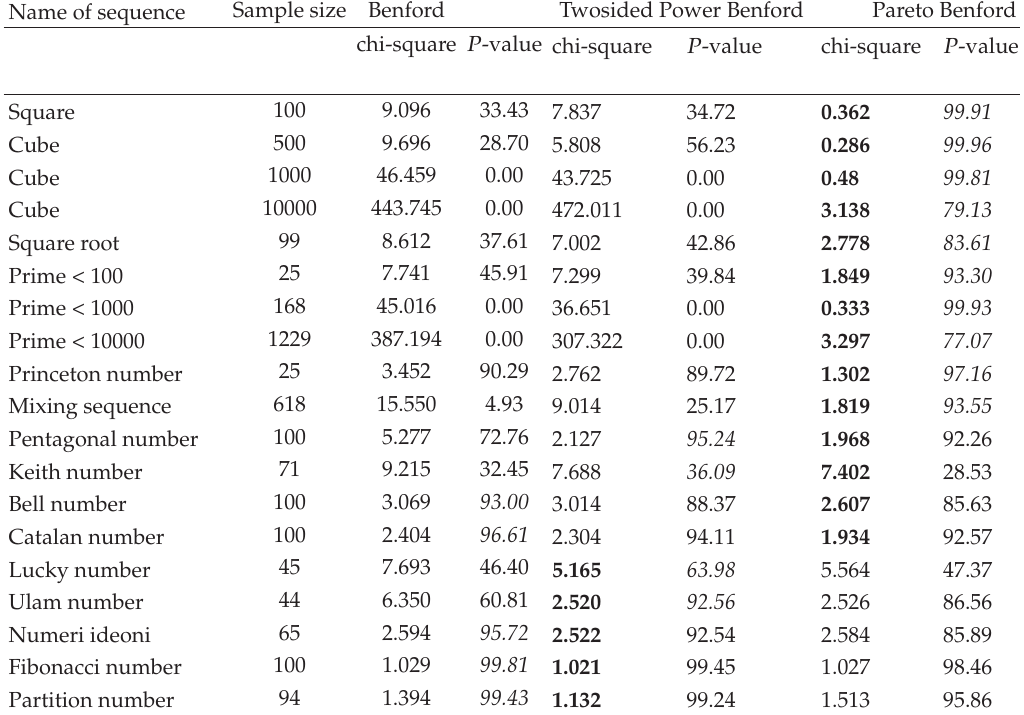
Table 3: Fitting integer sequences to the Benford and generalized Benford distributions Name of